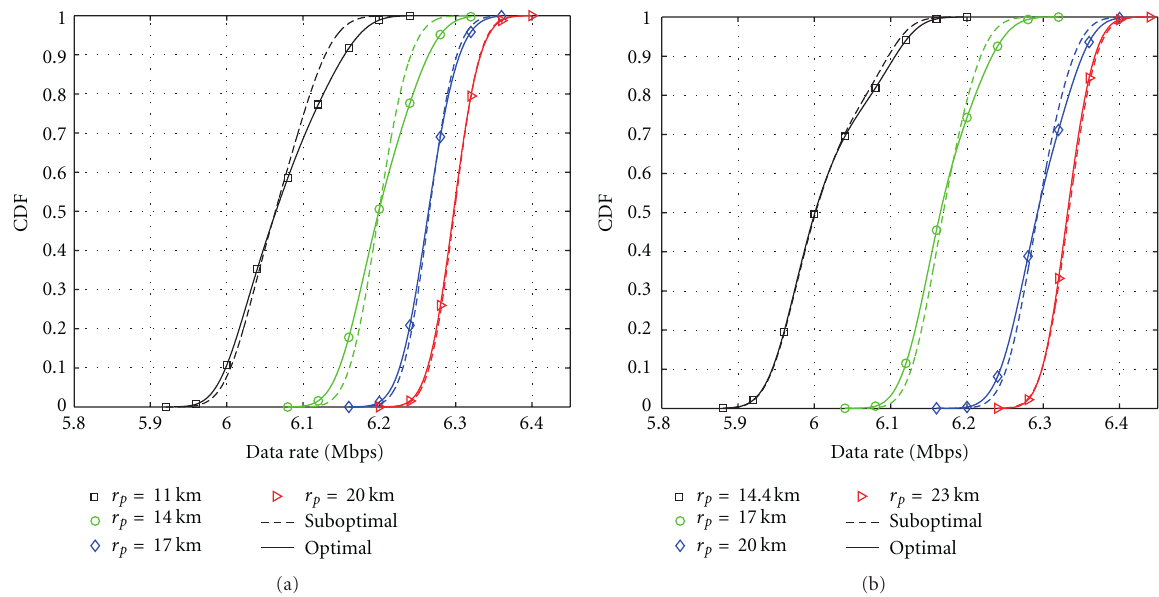
Figure 5: Distribution of average cell data rate for di ff erent protection distances. The cellular transmission power levels are obtained by solving the optimization problem (12a)–(12c) and also by solving the optimization problem (15a)–(15c). The cell radius is taken equal to (a) 1 km (b) 2